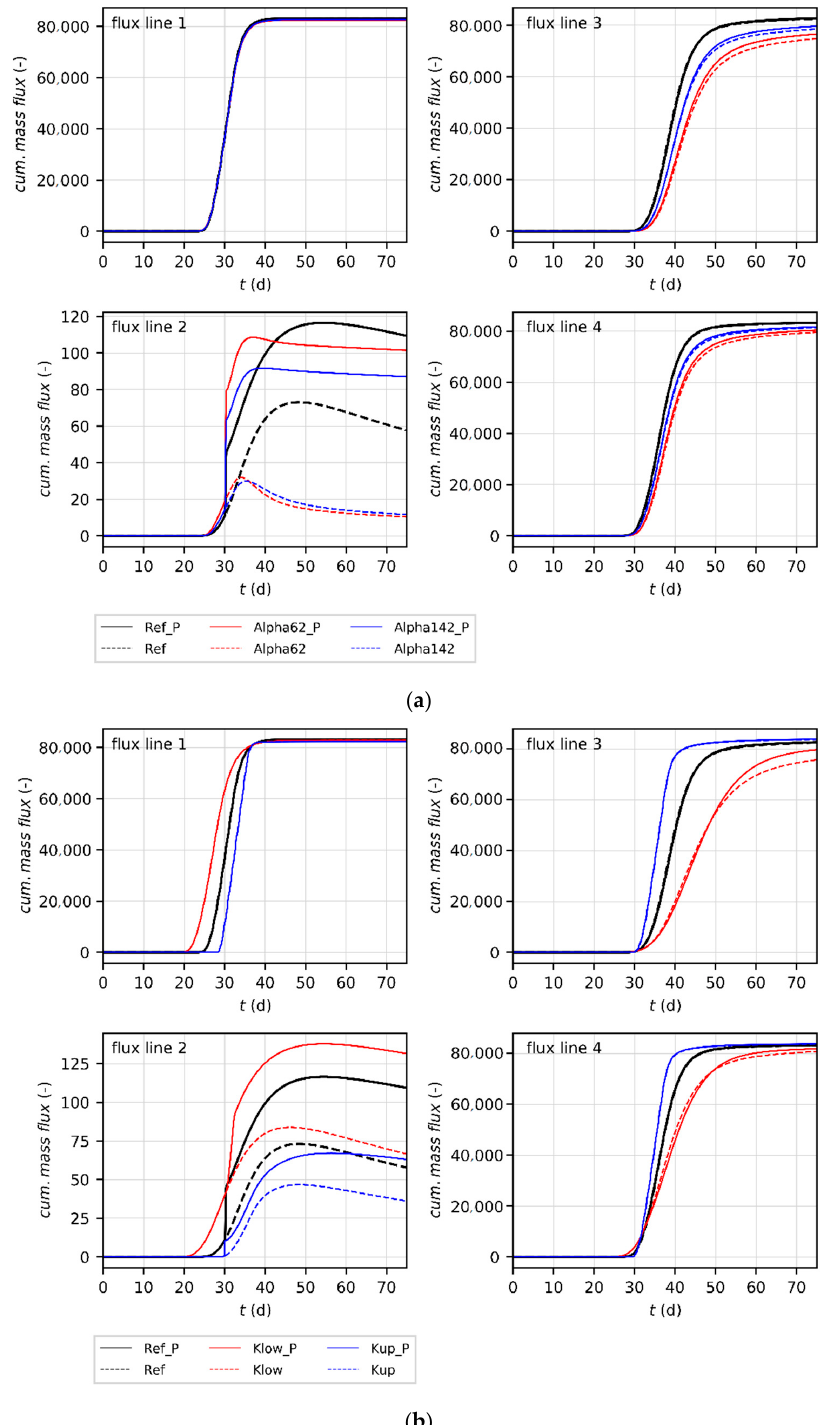
Figure 6. ( a ) Simulated values of cumulated solute mass flux over four flux lines, as shown in Figure 2, for the reference scenario and scenarios Alpha62 and Alpha142 (varying van Genuchten shape parameter α ). Note that cumulated mass fluxes could decrease due to reversed mass flux direction. _P indicates the scenarios with a precipitation event. ( b ) Simulated values of cumulated solute mass flux over the four flux lines, as shown in Figure 2, for the reference scenario and scenarios Klow and Kup (varying water-saturated hydraulic conductivity). Note that the conservative tracer labelled period was adapted for different scenarios of varied hydraulic conductivities. _P indicates the scenarios with a precipitation